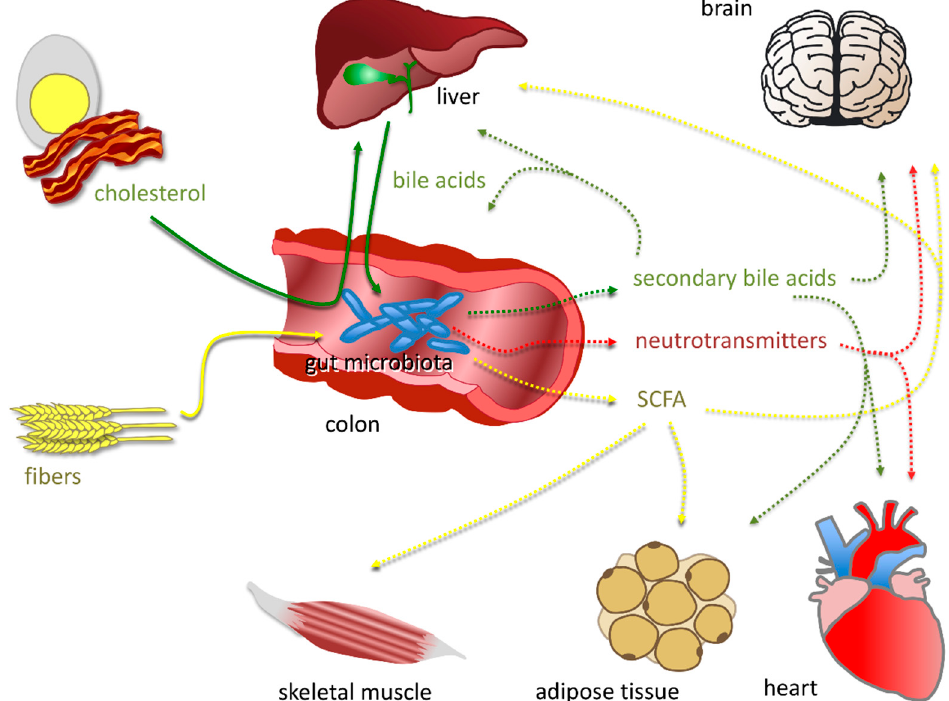
Figure 2. Dietary components are metabolized by gut microbiota into molecules with hormone-like properties. Dietary fibers (yellow) are metabolized into short chain fatty acids (SCFA), mainly composed of acetate, propionate and butyrate, which exert long-range effects on skeletal muscles, adipose tissue, and the liver and brain. Bile acids, first synthesized by the liver from endogenous or dietary cholesterol (green), are metabolized into secondary bile acids, acting on the intestinal wall, liver, brain, adipose tissue heart. The gut microbiota is also able to synthesize neurotransmitters (red) and neurotransmitter precursors that exert central effects. Solid line: dietary or bodily origin. Dotted line: compounds synthesized or transformed by gut microbiota.